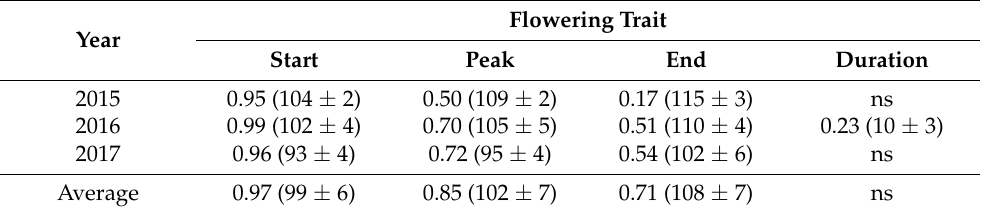
Table 2. Relationships of flowering start, peak, and end dates against cumulative temperature, as well as the flowering season length. Coefficients of determination are given, along with the average cumulative value and the standard deviation, in parenthesis; ‘ns’ indicates lack of significant